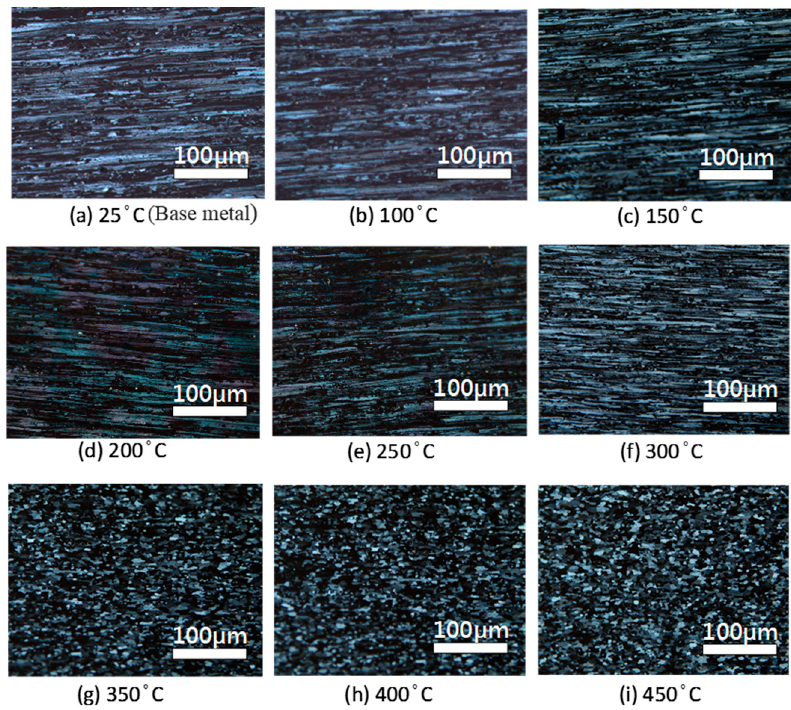
Figure 1. OM images of 5383-H116 Al-Mg alloy at different heat treatment temperatures. ( a ) 25 °C; ( b ) 100 °C; ( c ) 150 °C; ( d ) 200 °C; ( e ) 250 °C; ( f ) 300 °C; ( g ) 350 °C; ( h ) 400 °C; ( i ) 450 °C.